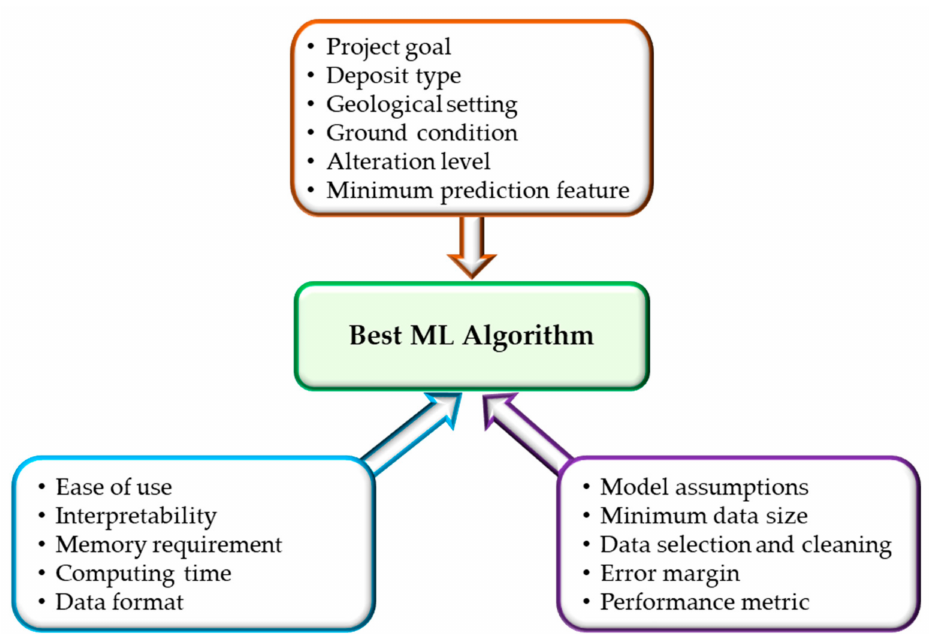
Figure 12. Schematic of ML Rubric factors for mineral resource